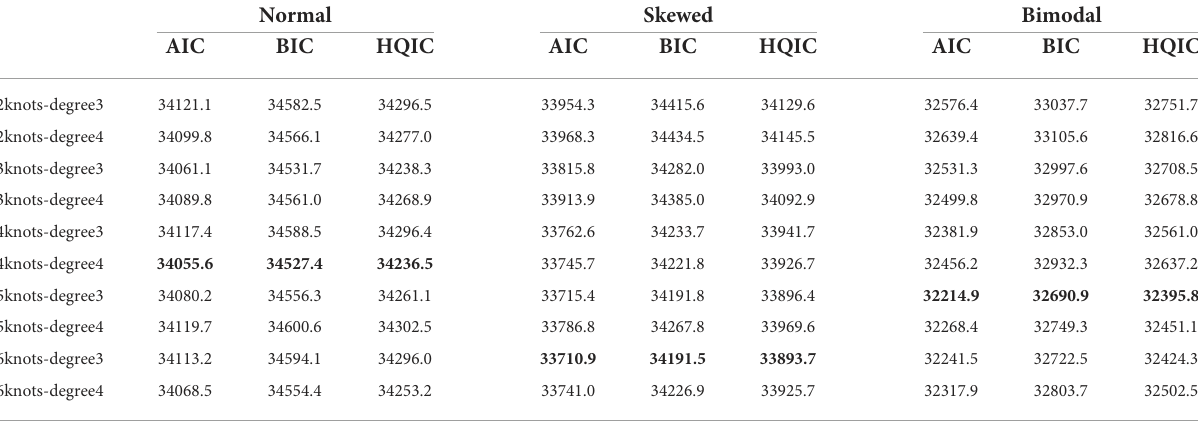
TABLE 1 Model selection results under different combinations of knots and degree when θ is normal, skewed, or bimodal. Normal Skewed AIC